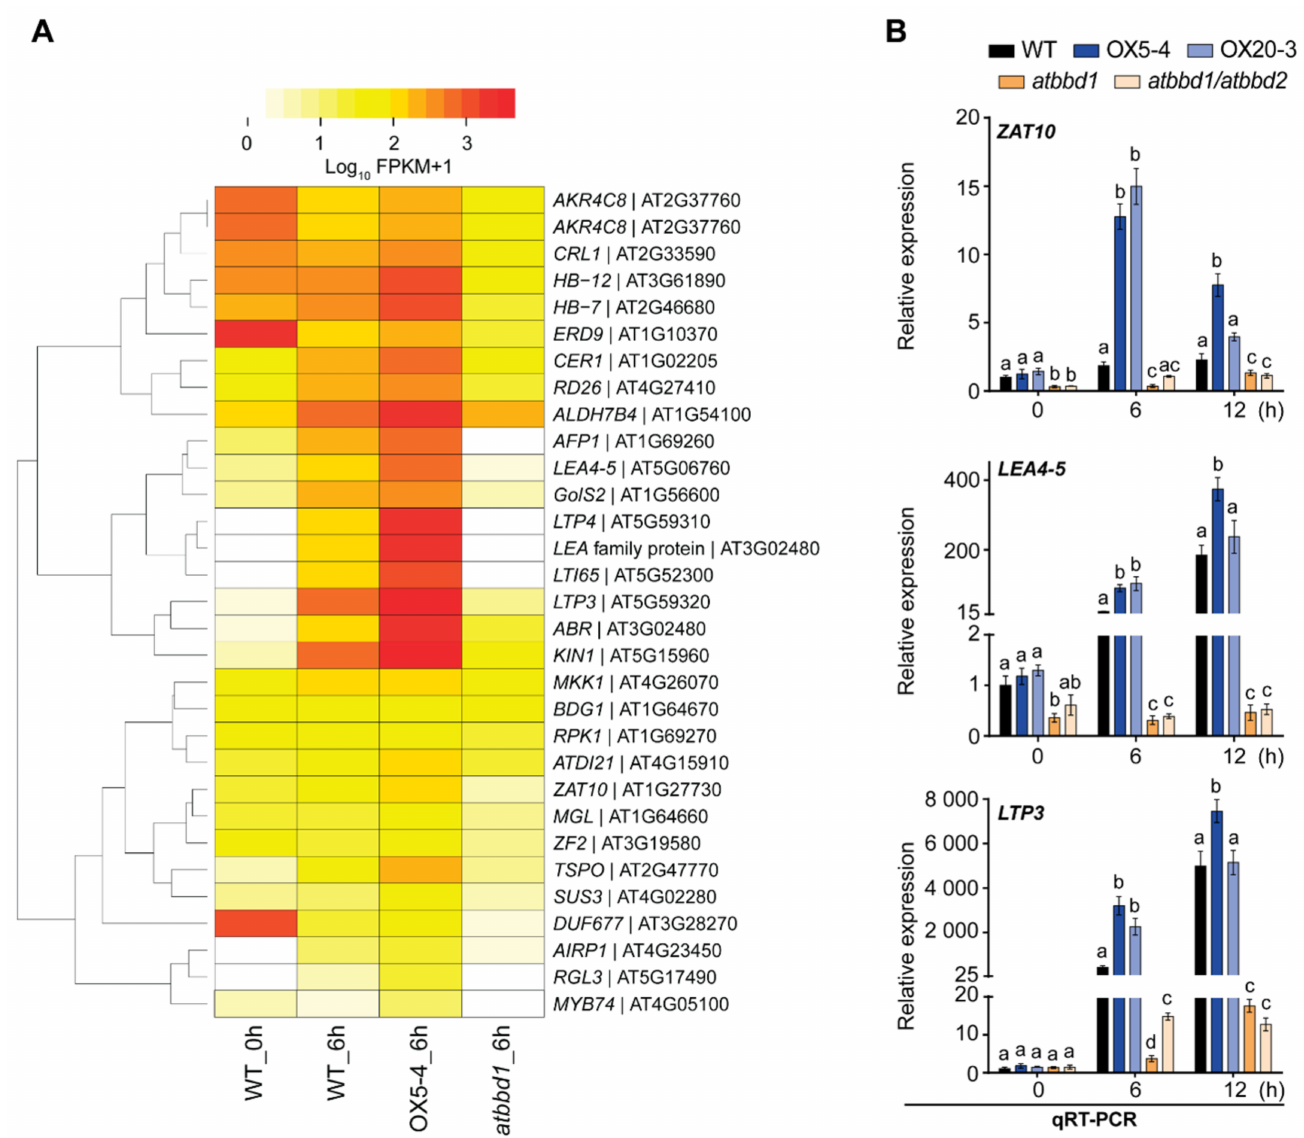
Figure 8. Expression of genes related to drought stress that appeared in RNA-seq data in the WT, OX5-4 and atbbd1 plants. Three-week-old soil-grown plants were stressed by watering with 20% PEG 6000 and gene expression was analyzed at designated time points. ( A ) Heatmap showing the expression (RPKM) of 31 drought responsive genes that are possibly regulated by AtBBD1 . ( B ) Relative expression levels determined by qRT-PCR of ZAT10 , LEA4-5, and LTP3 in the WT, OX5-4, and atbbd1 plants. The relative gene expression was calculated and normalized to the reference gene eIF4a1 . The normalized mRNA levels at 0 h were set to 1. Data represent the mean ± standard error values of three independent experiments. One-way ANOVA with post-hoc Tukey test was used for the statistical comparison of all genotypes. Different letters indicate significant differences among genotypes at each time point ( p <